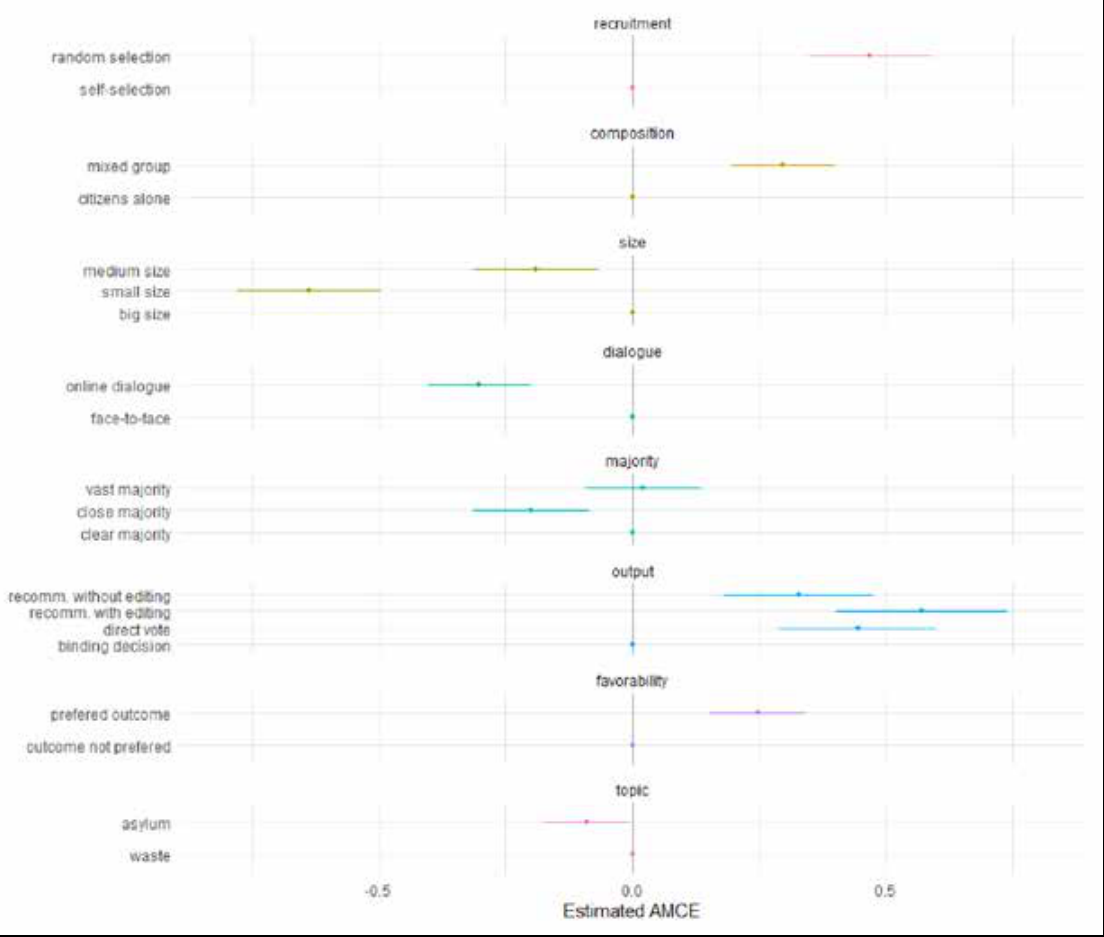
Figure 1: Effects of design characteristics on probability of choosing the scenario (y = rating outcome). Note: The figure shows AMCE and 95% confidence intervals. Estimates are based on the regression estimators with clustered standard errors; the first attribute level for each attribute is the reference category. The AMCE estimates show the average change in the rating of a scenario when it included the characteristics compared to the baseline category for each